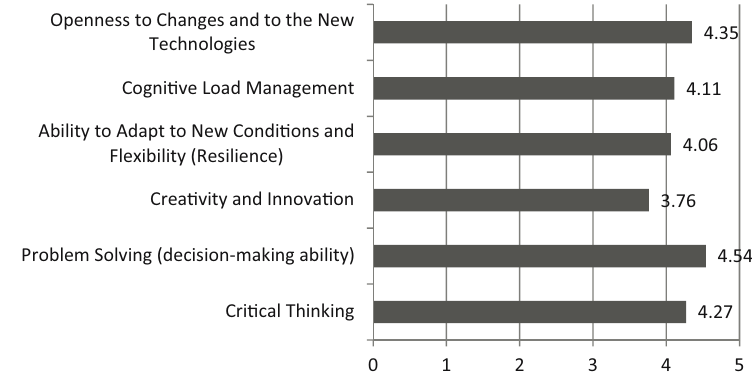
Figure 4: Cognitive competences, overall results. Source: author ’ s own study.